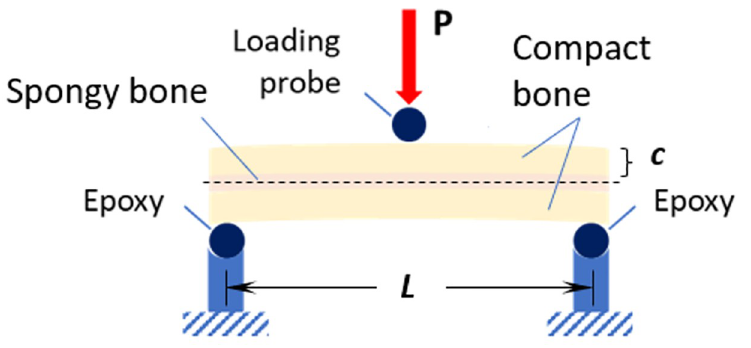
Fig 5. Setup for three-point bending tests of equine parietal bone beam-like specimens, where P is the applied load, c is distance from the midline to the outer surface and L is the span length.